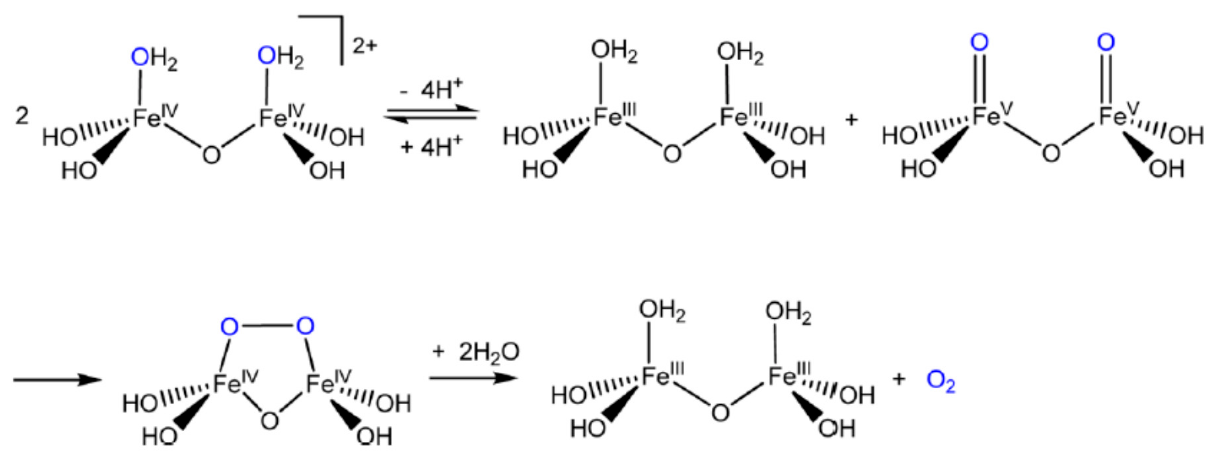
Figure 11. Oxidation of water molecules by Fe(IV) dimeric complex [126].